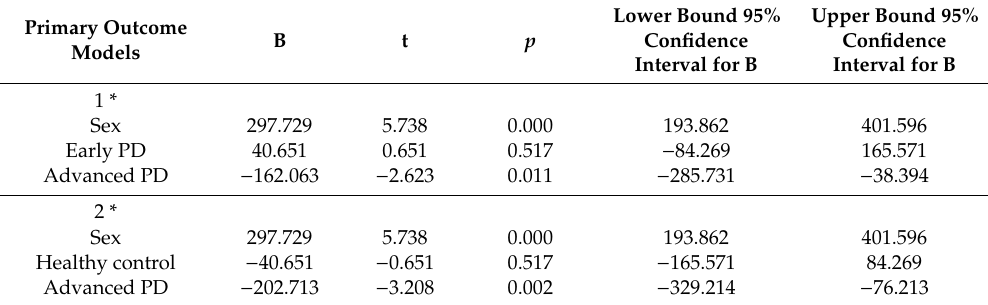
Table 3. Model 1: Regression model comparing energy intake (kcal) among advanced stage PD patients vs. healthy controls as well as early stage PD patients vs. healthy controls when controlling for sex. Model 2: Regression model comparing energy intake (kcal) among advanced stage PD patients vs. early stage PD patients when controlling for sex. Two outliers were excluded (Cook’s distance greater than (4/n)).